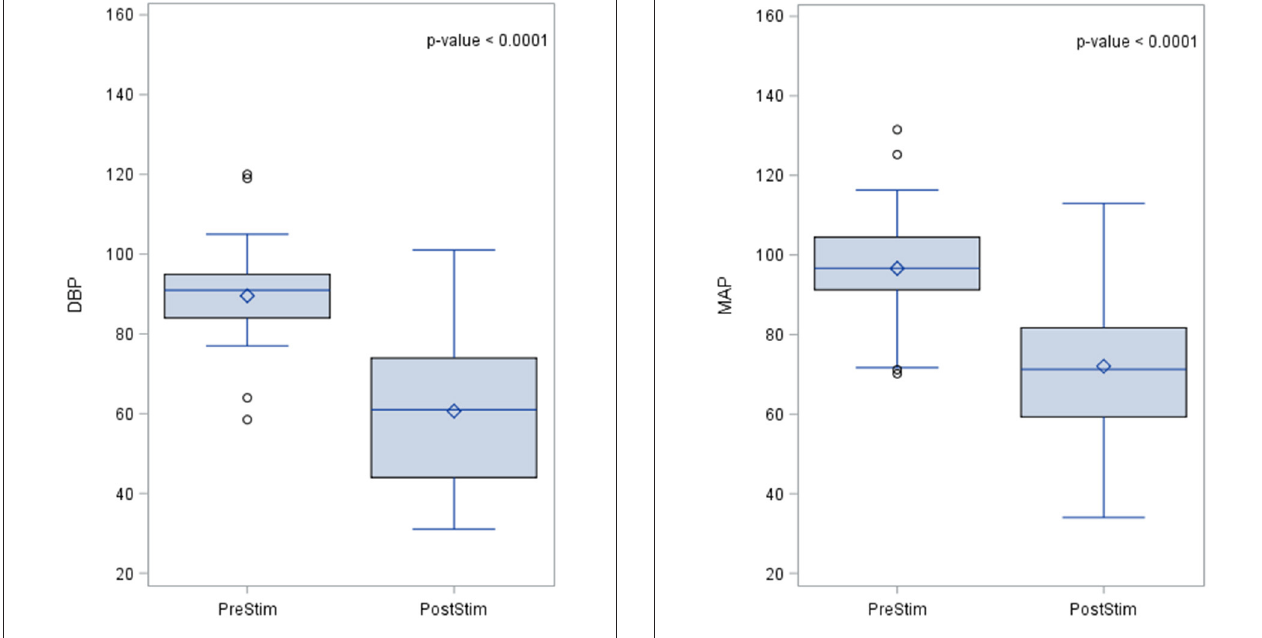
FIGURE 3 | Effects of aortic baroreceptor stimulation on diastolic blood pressure. The results of the distribution of the median are shown in the figure, together with the p -value after applying the Wilcoxin rank test. Diastolic blood pressure values are represented in mmHg.